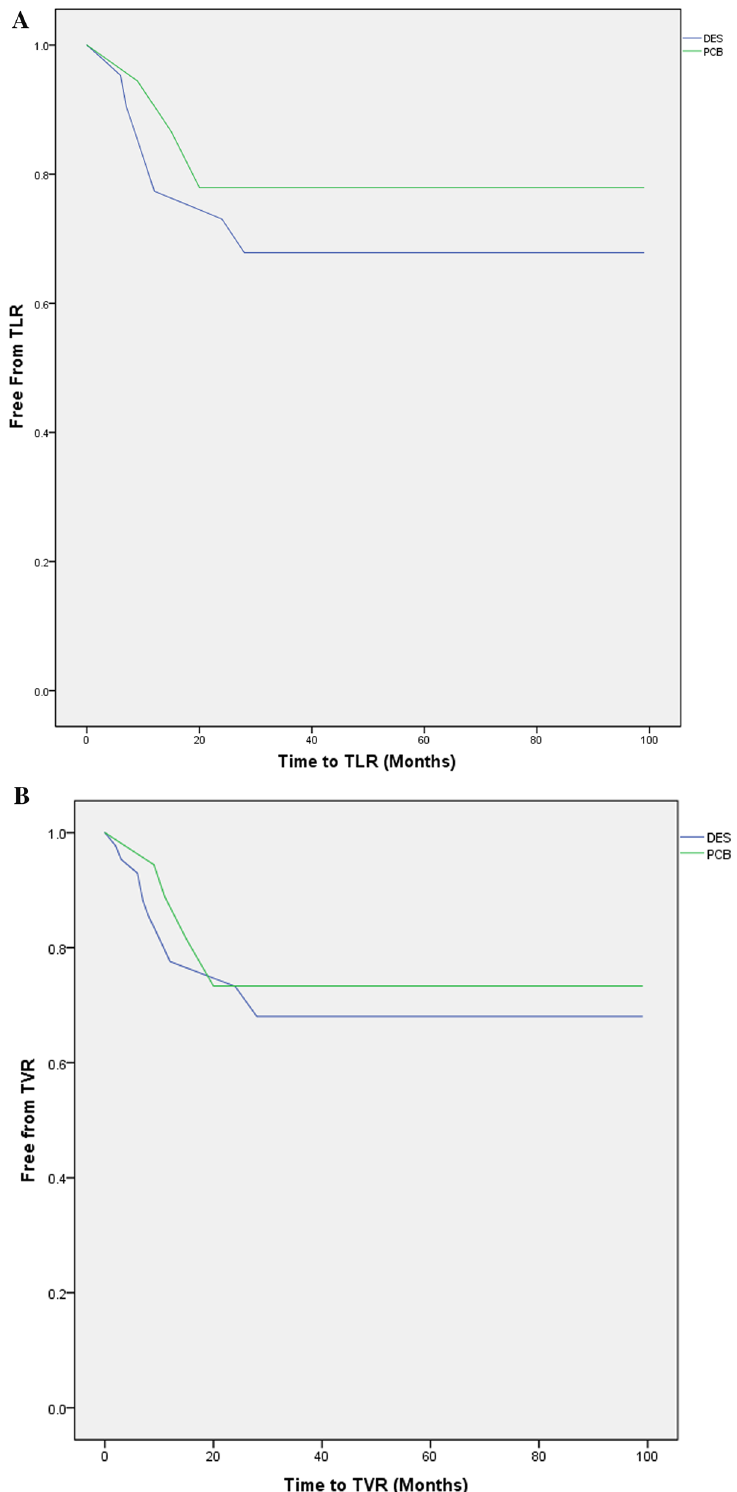
Fig. 1 Kaplan–Meier curves demonstrating free from events rates during the follow-up period between drug-eluting stent implantation and paclitaxel-coated balloon for the treatment of in-stent restenosis. A Survival rates free from target lesion revascularization, B Survival rates free from target vessel revascularization, C Survival rates free from myocardial infarction, D Survival rates free from major adverse cardiac events. DES Drug-eluting stent, MACE Major adverse cardiac event, MI Myocardial infarction, PCB Paclitaxel-coated balloon, TLR Target lesion revascularization, TVR Target vessel revascularization; these figures have been generated with the IBM ® SPSS ® software Statistics